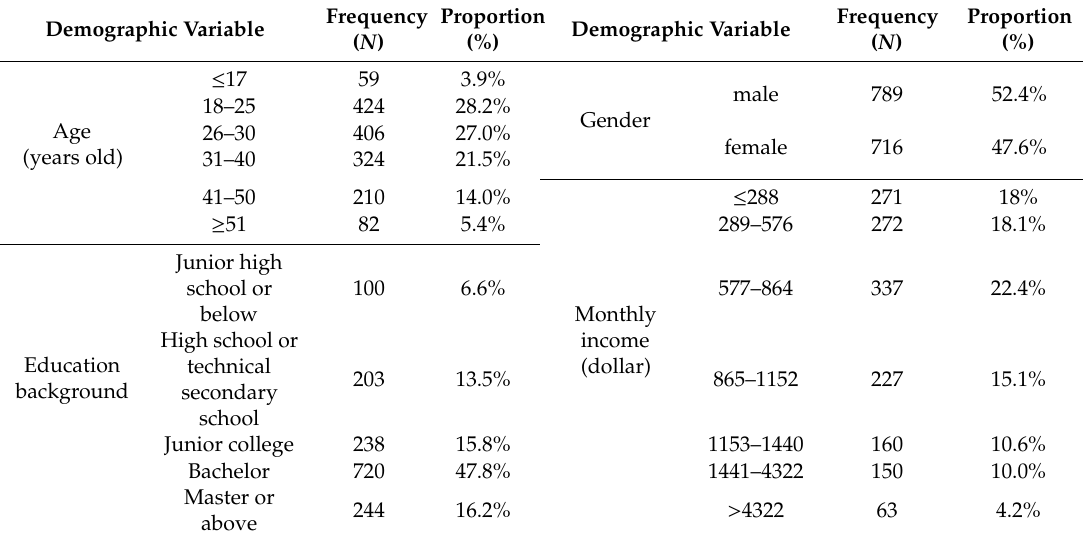
Table 2. Sample distribution of formal